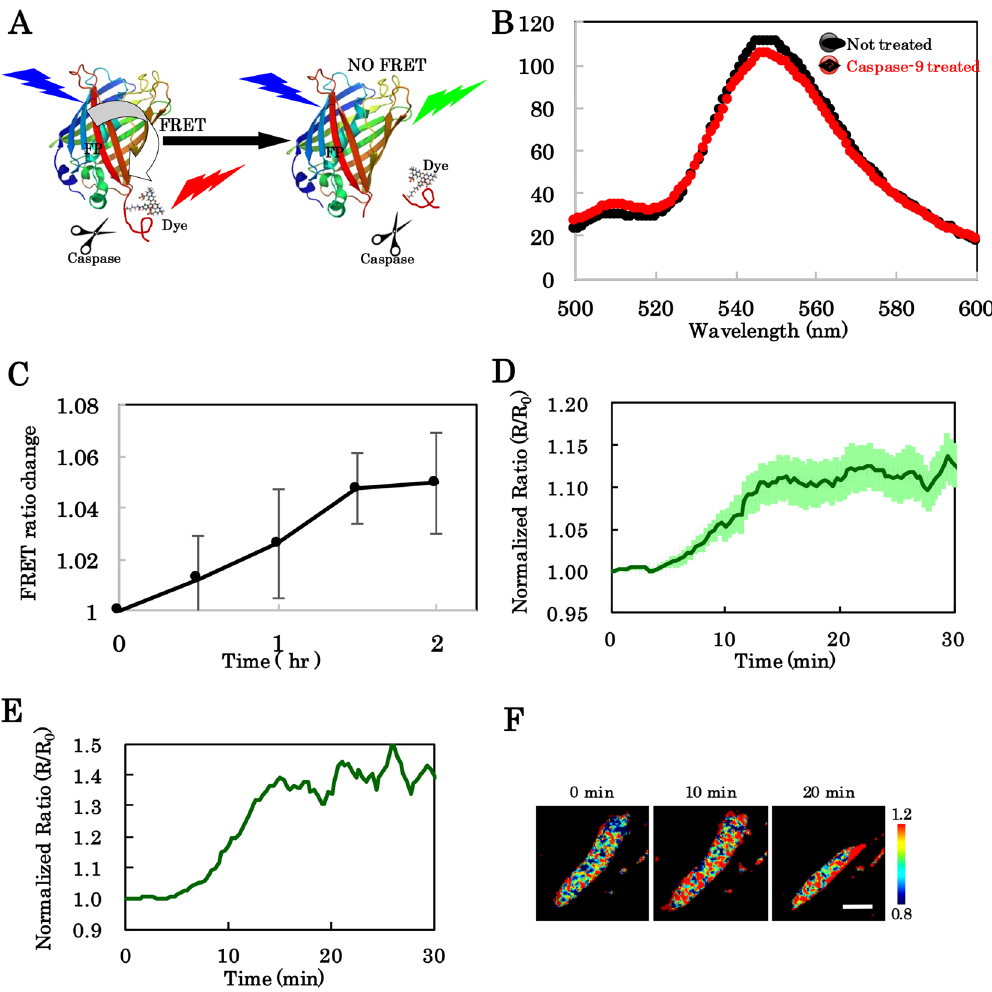
Figure 2. Functional mechanism and detection properties of caspase-9 with FRET-based chimeric bioprobe. ( A ) Schematic of FRET-based sensing upon caspase treatments ( B ) Emission profile with or without caspase-9 treatments of bioprobe consisting of donor molecule (GFP) and acceptor molecule (Alexa Fluor 532). ( C ) Time-dependent FRET ratio change of the bioprobe after capase-9 treatment in vitro. (n = 3, values represent mean ± SD) ( D ) Averaged time-dependent FRET ratio change of the bioprobe after introduction into HeLa cells after apoptosis induced with TNF-α and cycloheximide at 0 min. (n = 17 cells). Error bars indicate SEM. ( E ) Representative time-dependency of the bioprobe response extracted from ( D ). ( F ) Pseudo-colour images for FRET ratios observed at three different time points from